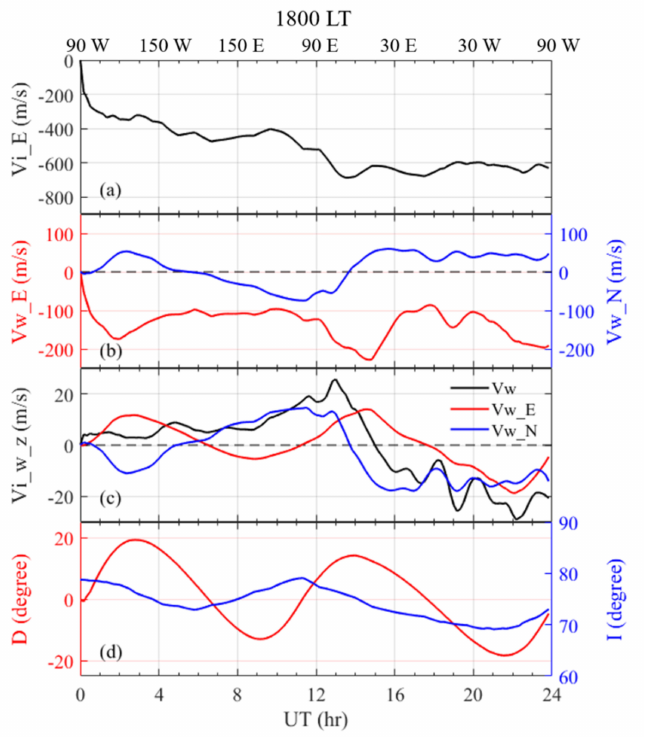
Figure 7. The averaged differential ( a ) eastward ion velocities V i_E , ( b ) eastward ( V w_E ) and north- ward ( V w_N ) neutral wind velocities, ( c ) vertical ion velocities induced by different components of neutral wind, and ( d ) geomagnetic declination and inclination between SAPS-TIEGCM and default-TIEGCM in SAPS channel at 1800 LT.